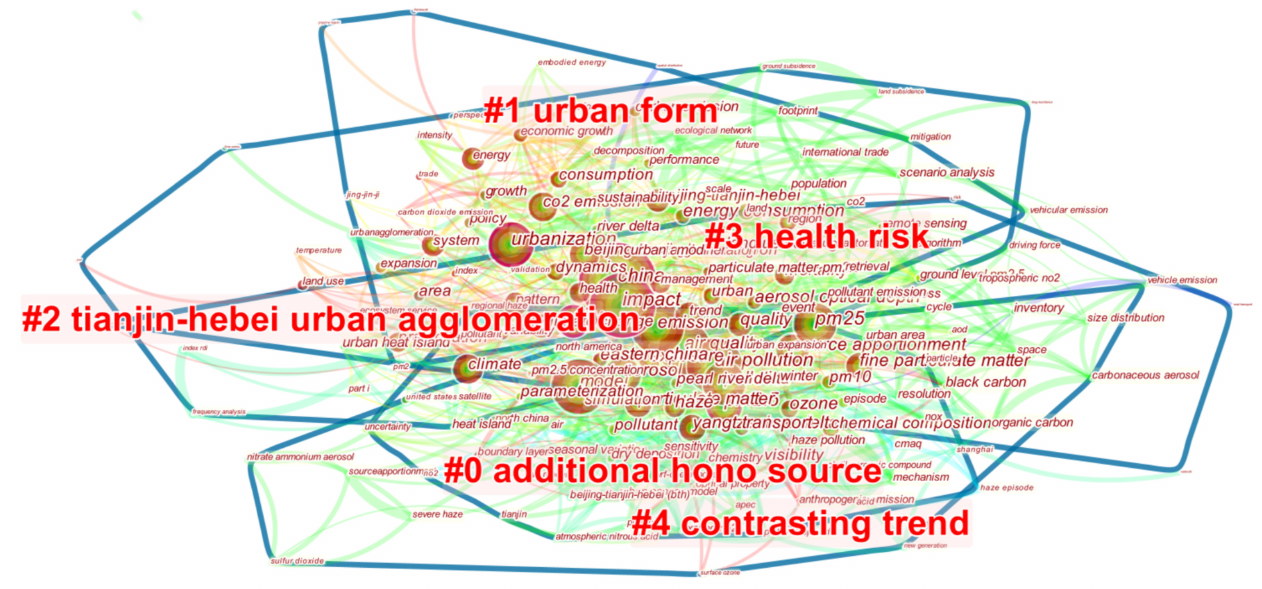
Figure 1. Keyword clustering map.